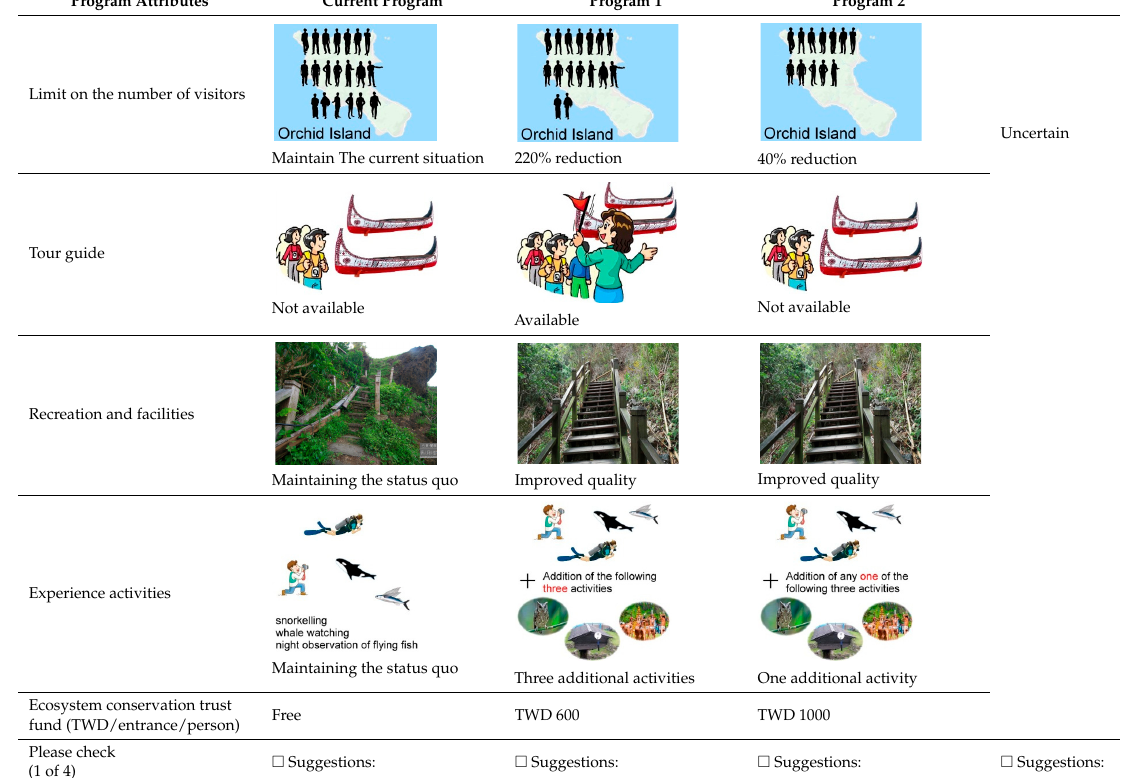
Table 2. An example of the choice set of Orchid Island preferences and programs.